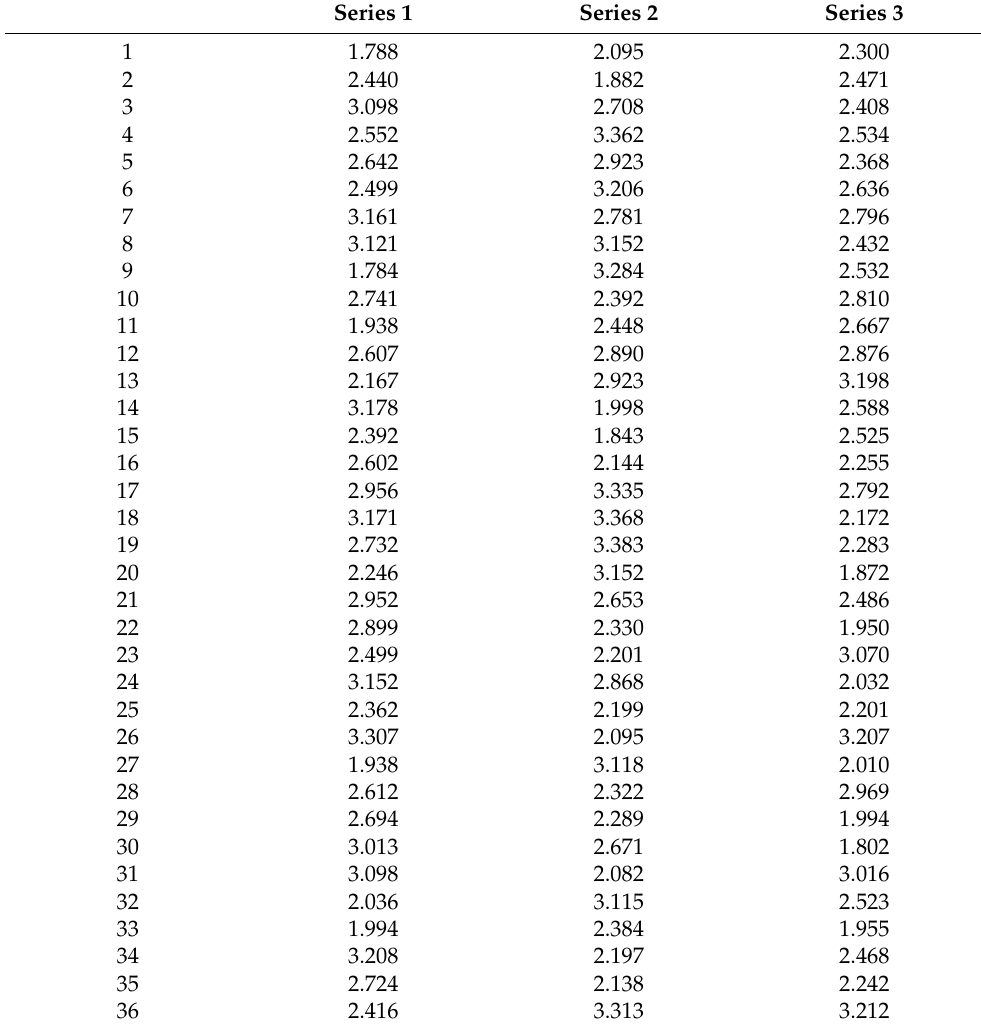
Table A3. Ultrasonic R joint quality measure for the first three measurement